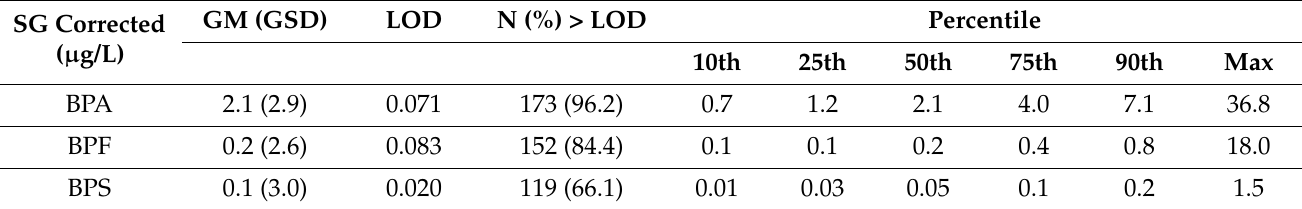
Table 2. Distribution of the maternal urinary bisphenol concentration of the study population ( n = 180).